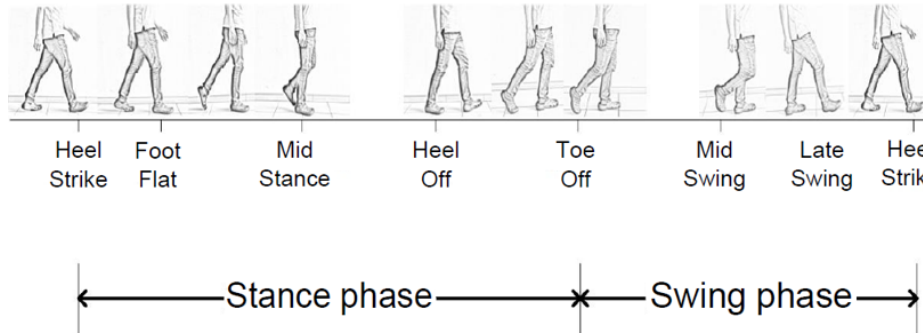
Figure 2. Phases of a typical gait cycle.